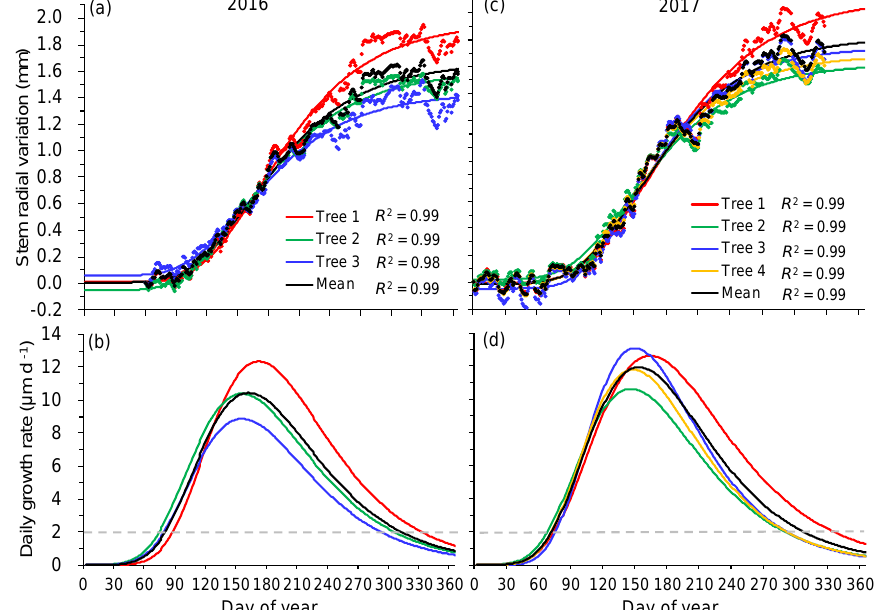
Figure 4. Observed and modeled stem radial variations ( a , c ) and associated daily growth rate ( b , d ) of Taiwan pine in 2016 and 2017. Dots and lines in top panels represent raw measurements of daily maximum radius and Gompertz function modeled curves, respectively. Dashed lines in the bottom panels indicate daily growth rates equal to 2 μm day −1 , which correspond to the dendrometer accuracy.